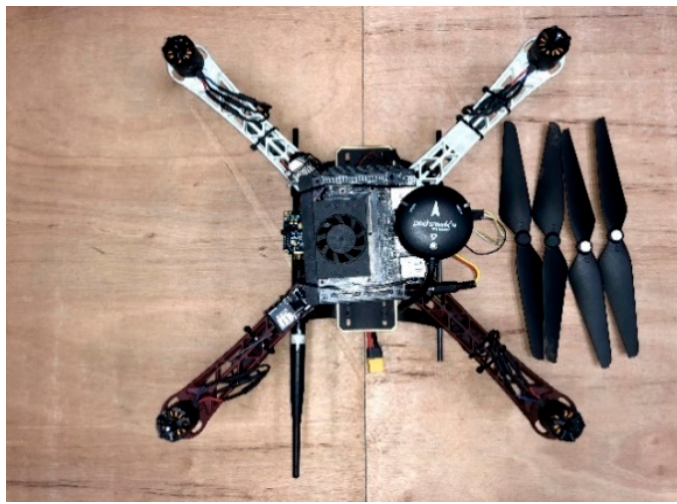
Figure 12. Prototype UAV.